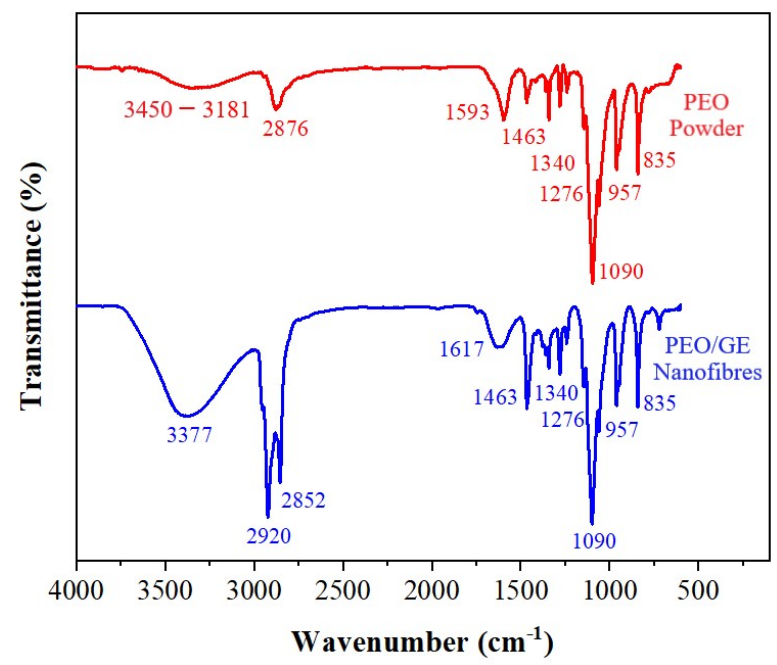
Figure 4. FTIR spectrum of PEO powder (red) and PEO/GE (blue) nanomembranes . In the blue curve, signifying PEO 5% GE 30% , there is the appearance of some visible